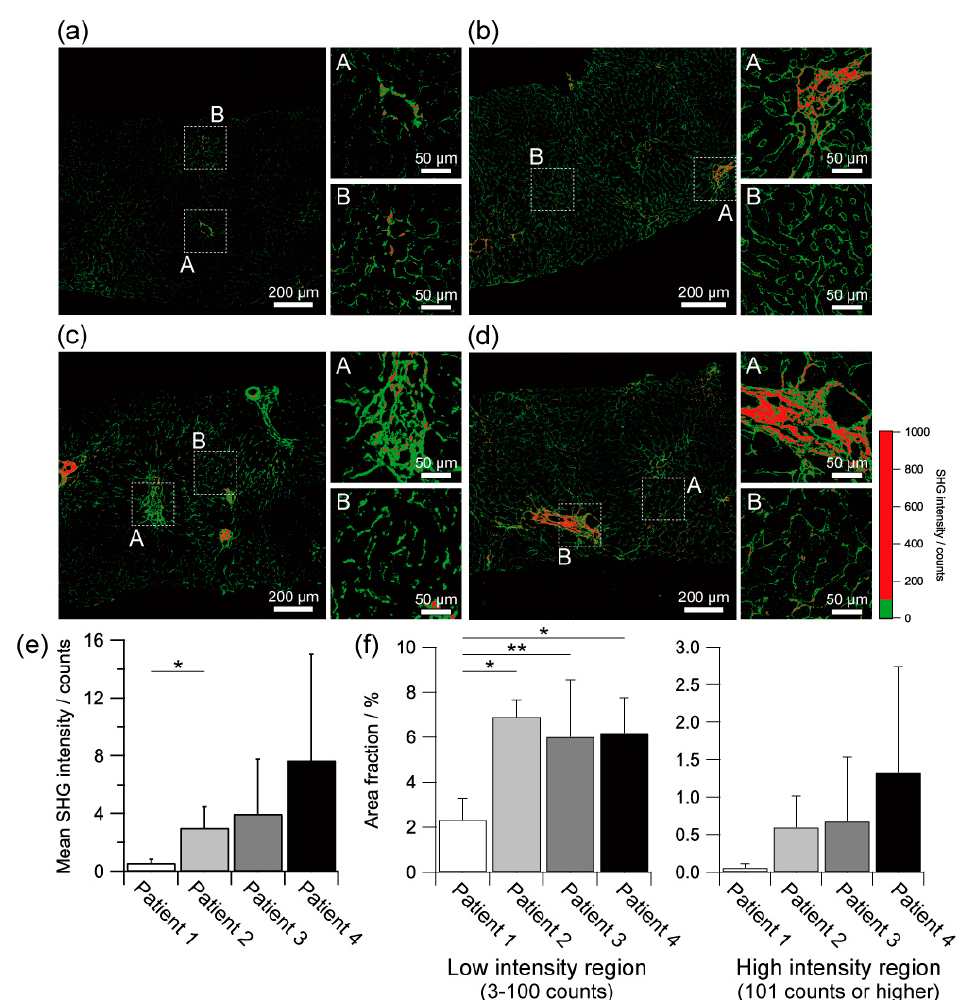
Figure 3. SHG intensity-based analysis of the liver fibrosis of NAFLD patients. Stronger SHG inten- sity (red) and weaker SHG intensity images (green) of the livers of ( a ) ultra-early stage of NAFLD (Patient 1), ( b ) ultra-early stage of NAFLD (Patient 2), ( c ) early stage of NASH (Patient 3), and ( d ) advanced stage of NASH (Patient 4). ( e ) Mean SHG intensity of each NAFLD patient. ( f ) Area frac- tion of lower and higher SHG intensity regions of each NAFLD patient. Asterisks indicate a statis- tically significant difference (* p < 0.01, ** p < 0.05). Error bar, standard deviation.